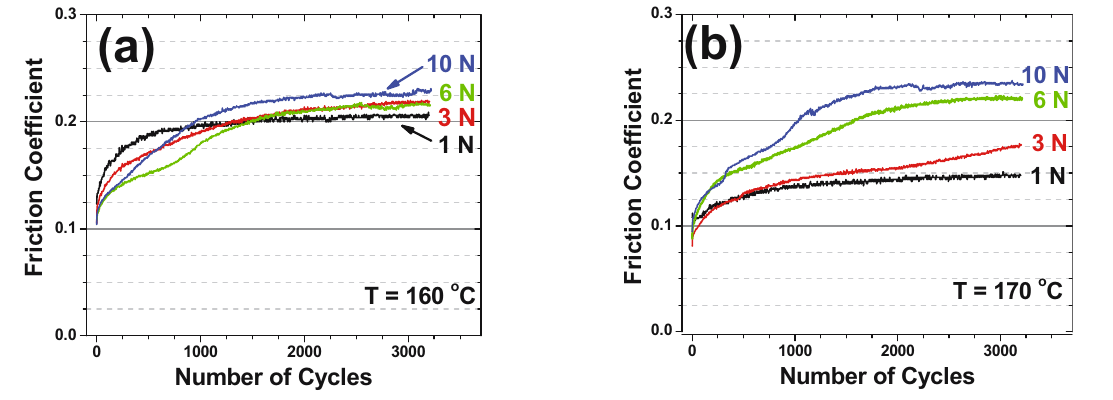
Figure 4: Friction coe ffi cient versus the number of cycles at di ff erent loads for samples made at ( a ) 160°C and ( b ) 170°C. The wear track is perpendicular to the textured lines of the surface.